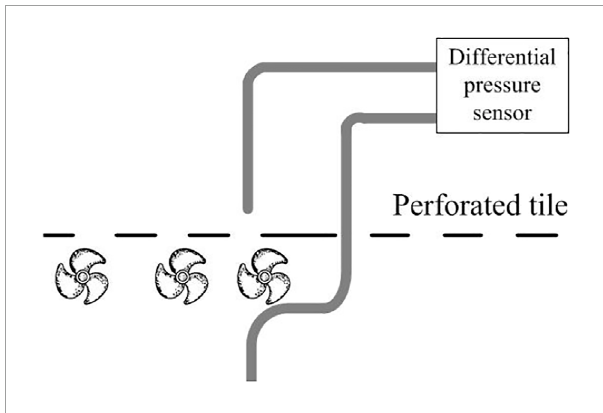
FIGURE 7 Pressure differential measurement for the active tile.